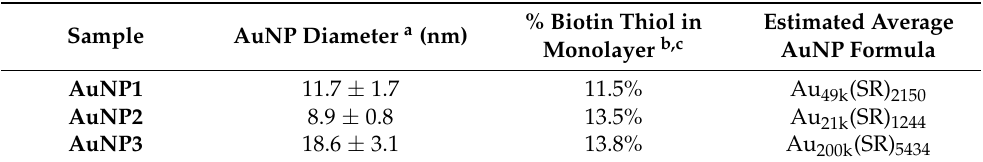
Table 1. Monolayer composition of AuNPs after thiol exchange with biotinylated thiol 1 employed in this work.